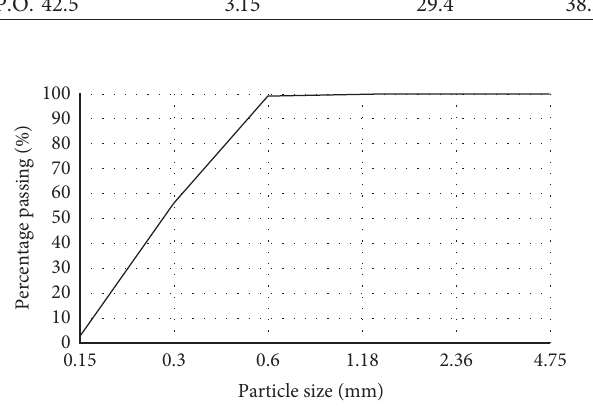
Figure 1: Grading curve of quartz sand. Table 3: SF chemical composition.